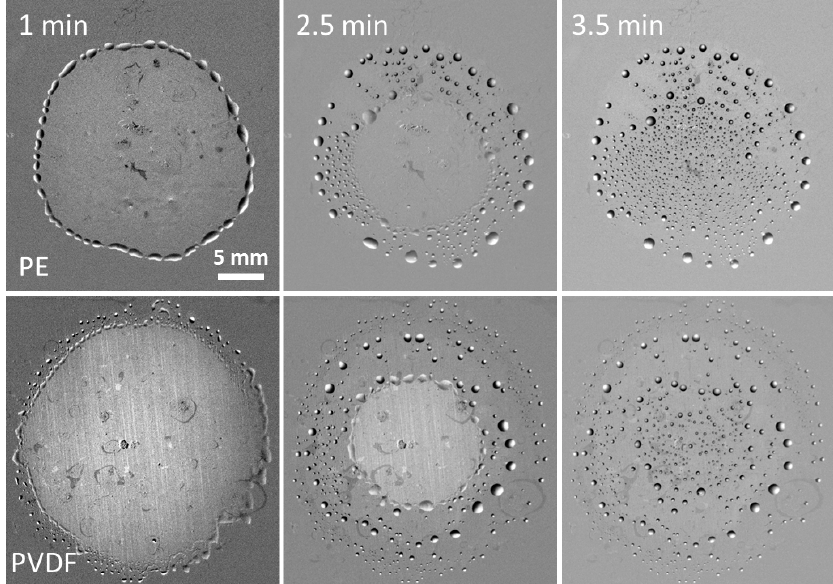
Figure 6. De-wetting patterns formed by a spread 5 µ L drop of 5 g / L solution of BT-278 in 30% glycerol / water mixture on PE (top row) and PVDF (bottom row) substrate. Zero time corresponds to the release of the drop onto substrate.